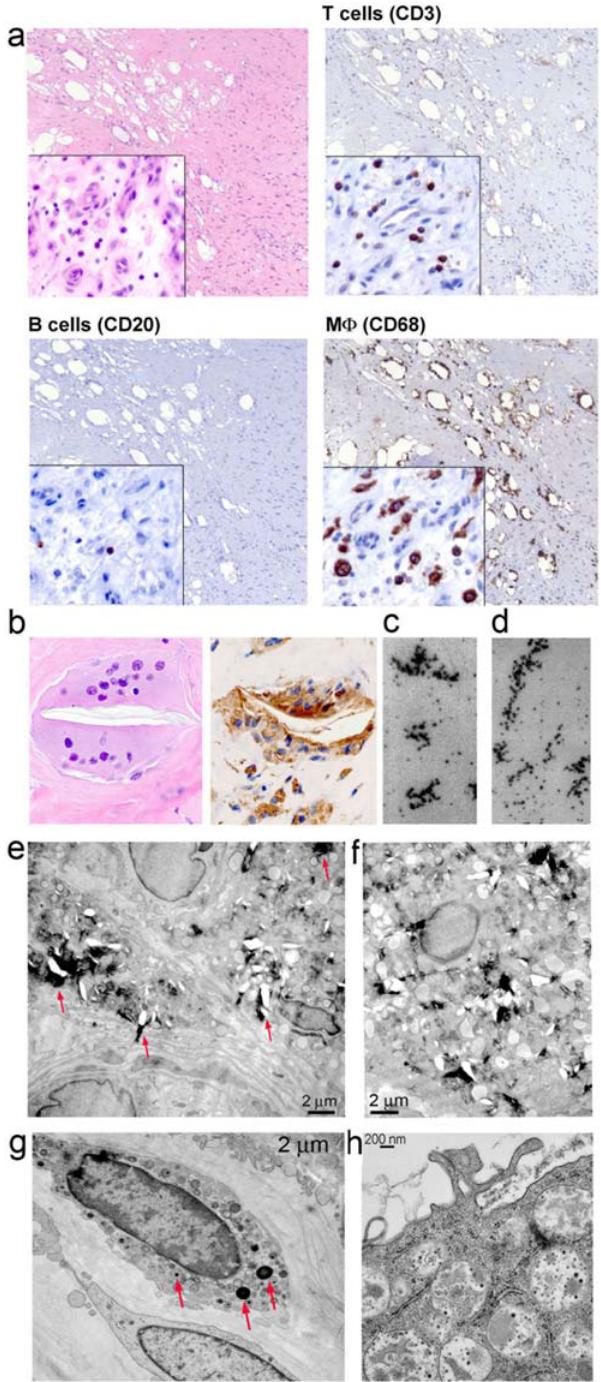
Figure 1. Periprosthetic inflammatory reaction to micron and sub-micron size modified n-alkane polymers. a) Immunohisto- chemistry of periprosthetic tissue retrieved at the time of the implant revision surgery (20X magnification and 40X for inset). The tissue was stained with: hematoxylin and eosin to detect total cell infiltrates, CD3 to detect T cells, CD20 to detect B cells and CD68 to detect macrophages. PE polymers of varied shapes and sizes are visualized as transparent areas. b) Hematoxylin and eosin staining (right) and CD68 (left) showing a multi-nucleated giant cell surrounding a large PE particle. c and d) Electron micrograph of sub micrometer PE particles c) purified from periprosthetic tissue or d) chemically synthesized mPE particles shown as control. e, f, g and h) Electron micrograph of